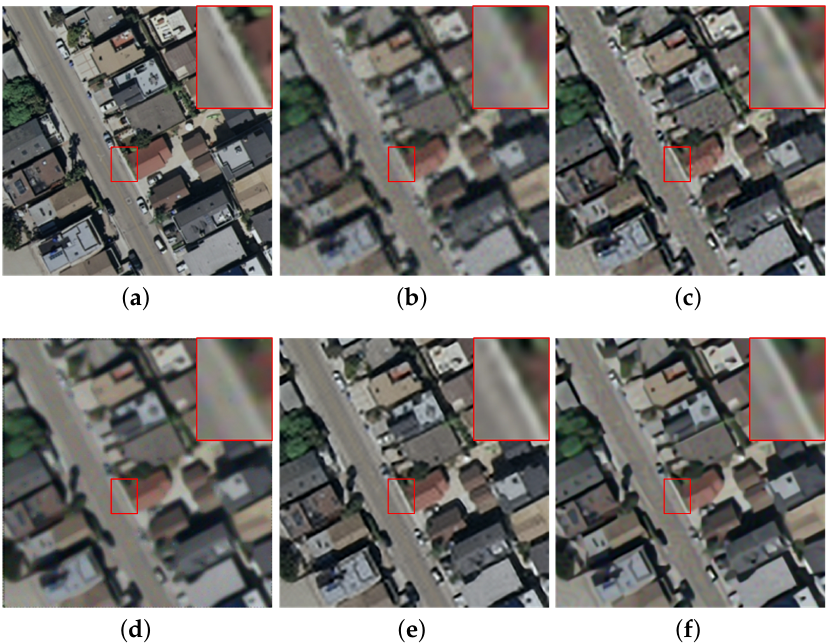
Figure 8. The reconstruction for the residential of noisy image with different methods (noise = 5). ( a ) original image. ( b ) bicubic interpolation (PSNR:22.05, SSIM:0.6359, ERGAS:6.6547). ( c ) ASDS (PSNR:26.16, SSIM:0.7958, ERGAS:4.1301). ( d ) NARM (PSNR:23.61, SSIM:0.6981, ERGAS:5.6835). ( e ) MSEPLL (PSNR:26.21, SSIM:0.8071, ERGAS:4.0817). ( f ) ours (PSNR:26.47, SSIM:0.8209,